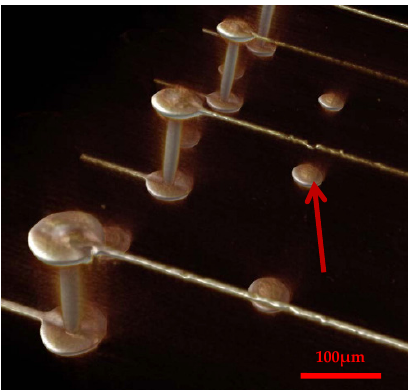
Figure 14. Three-dimensional stained image rendered using 3D Viewer software.